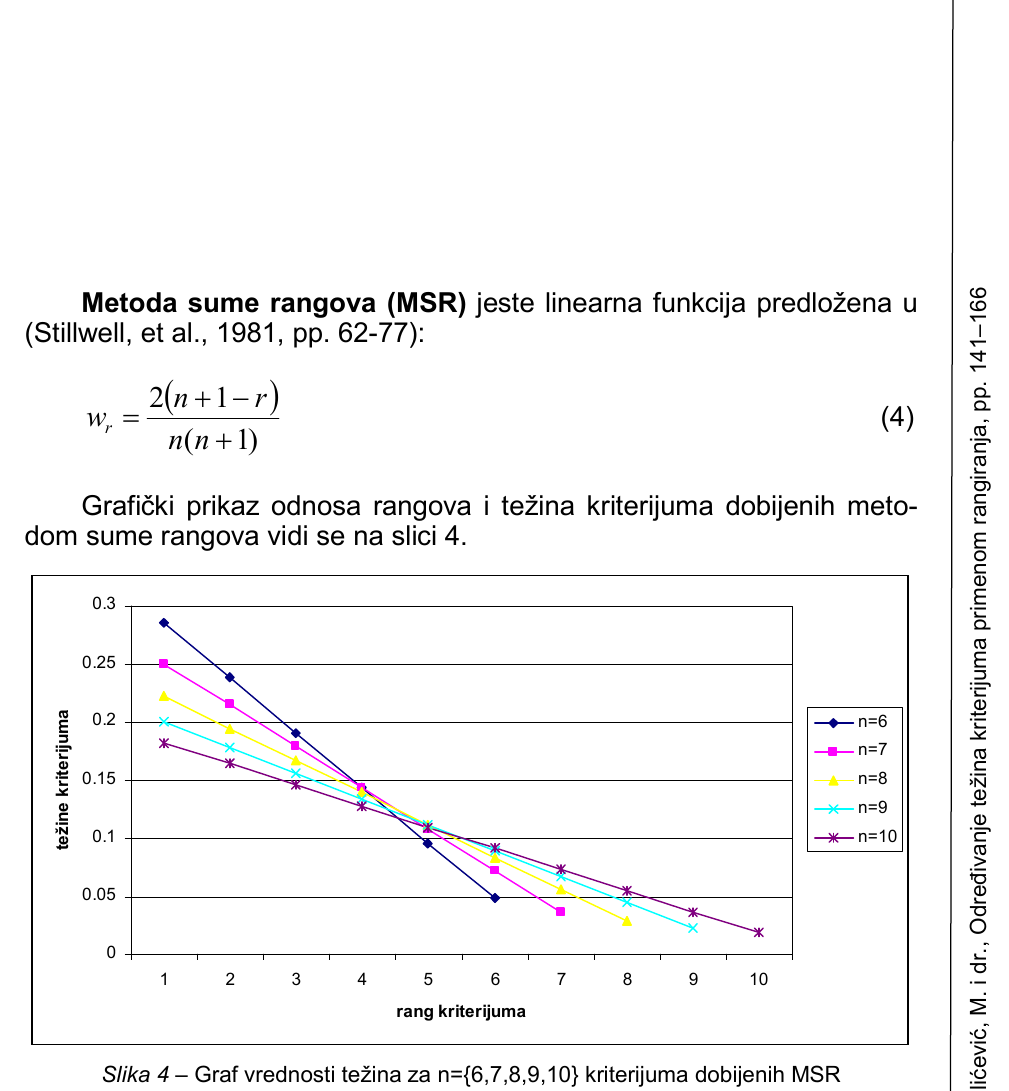
Figure 4 – Graph of the weight values for n={6,7,8,9,10} of the criteria obtained by the RSW Raspodela verovatno ć a rangova (RVR) - polaze ć i od pretpostavke da rangovi kriterijuma podležu ravnomernoj raspodeli verovatno ć a za br- oj kriterijuma n =2 do n =10, Roberts i Goodwin (2002) razvili su gustine raspodele verovatno ć a normalizovanih težina i, na osnovu njih, izvršili prora č un vrednosti težina kriterijuma. Kao primer navode se gustine ras- podele verovatno ć a normalizovanih težina za broj kriterijuma